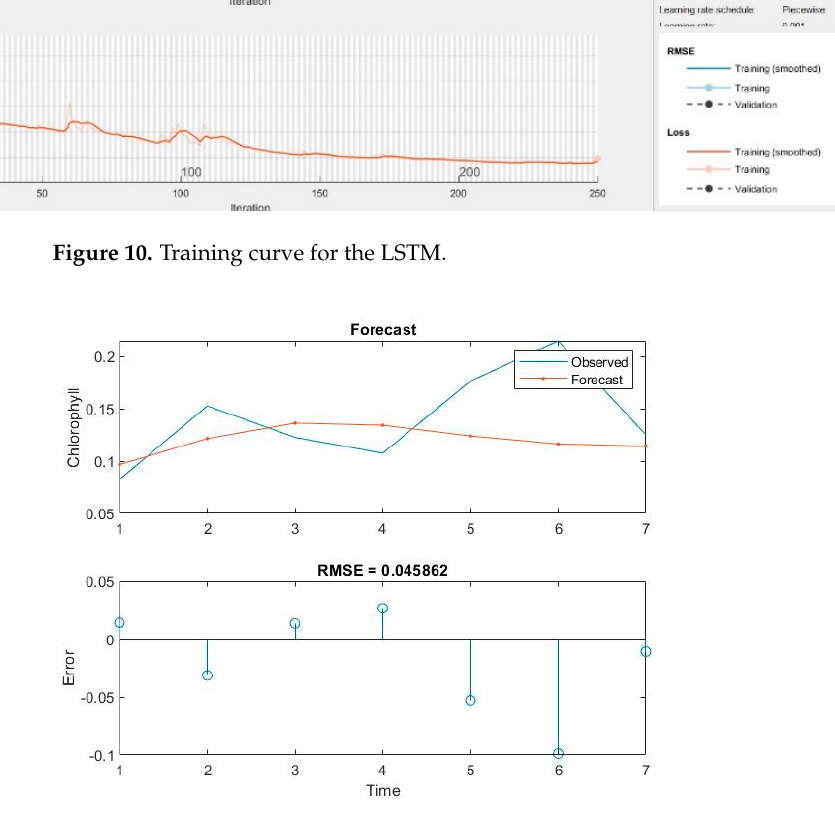
Figure 11. RMSE for chlorophyll prediction using LSTM.